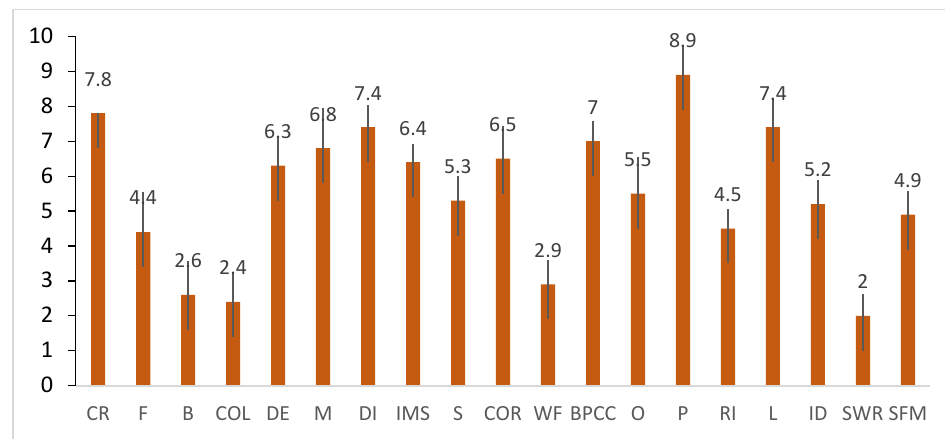
Figure 9. Mean values of 𝐷 .